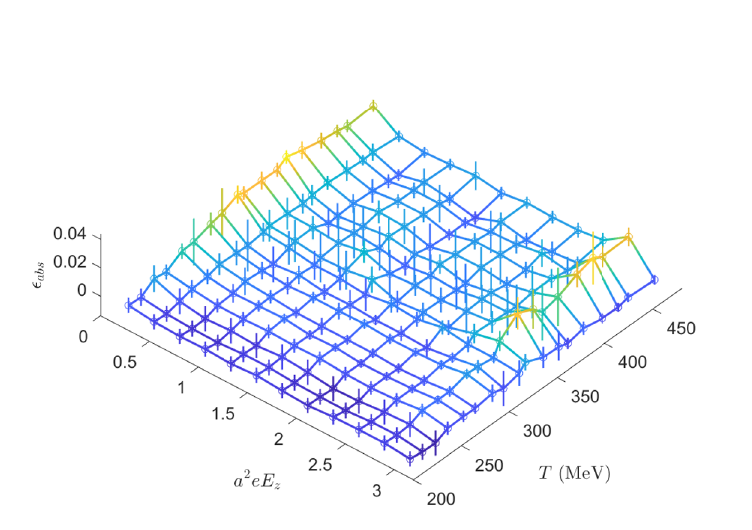
Figure 25 . (cid:15) abs as a function of T and E z